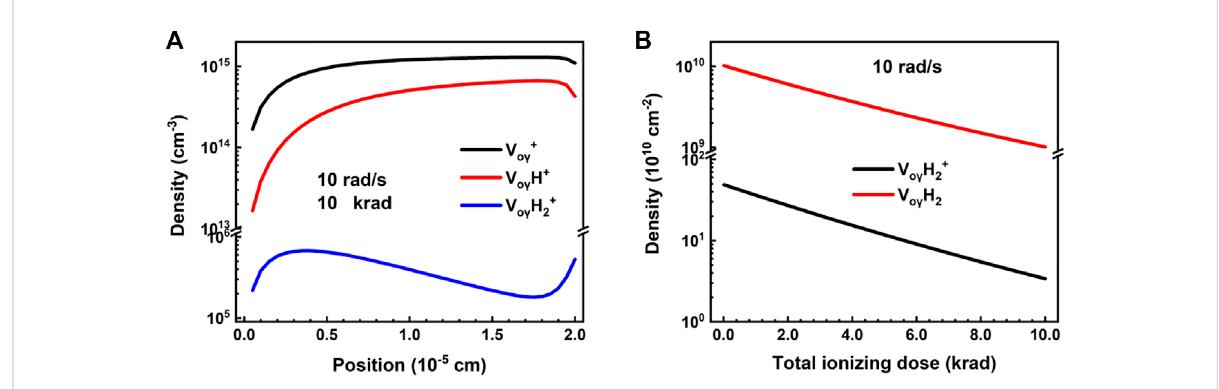
FIGURE 3 Distributionsof (A) differentoxidechargeddefectsundertheTIDof10 krad,and (B) evolutionof V o γ H + 2 and V o γ H 2 withthedoserateof10 rad/s at 300 K.